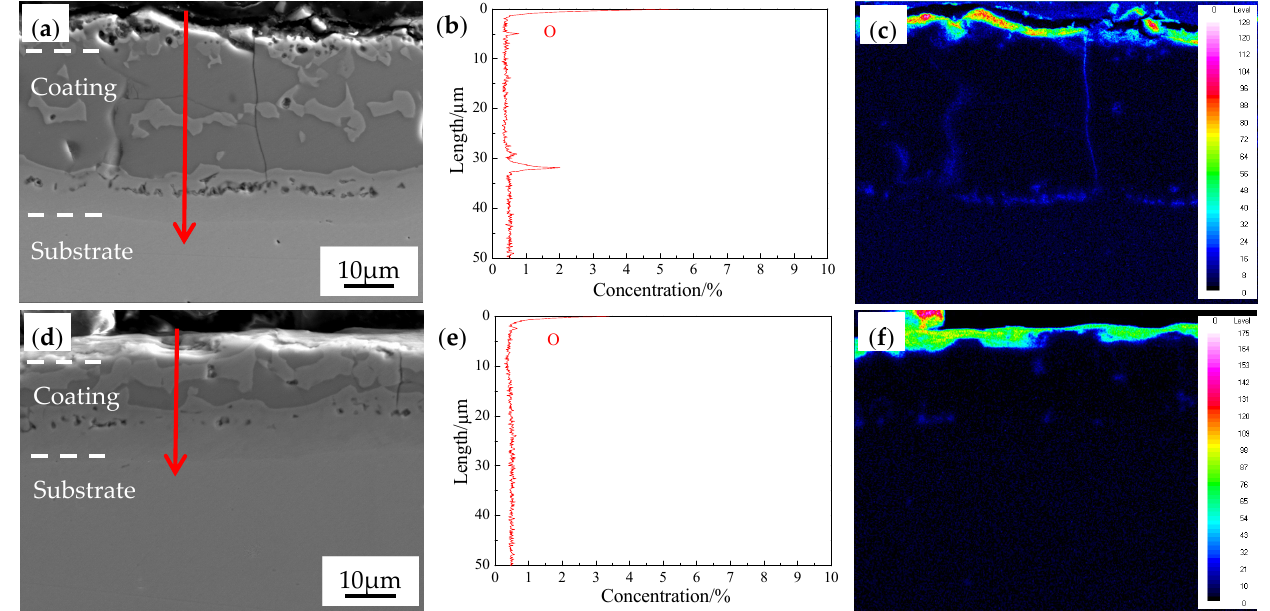
Figure 16. EPMA of interface between the AS60/60 coating and the steel substrate at TAUS = 930 °C for 5 min: ( a , d ) AS60/60 coatings at 0% and 50% reduction ratio, respectively, and ( b , e ) the corre- sponding EDS line scan results obtained along the red arrow; ( c , f ) EDS map scan results of oxygen element at 0% and 50% reduction ratio, respectively.